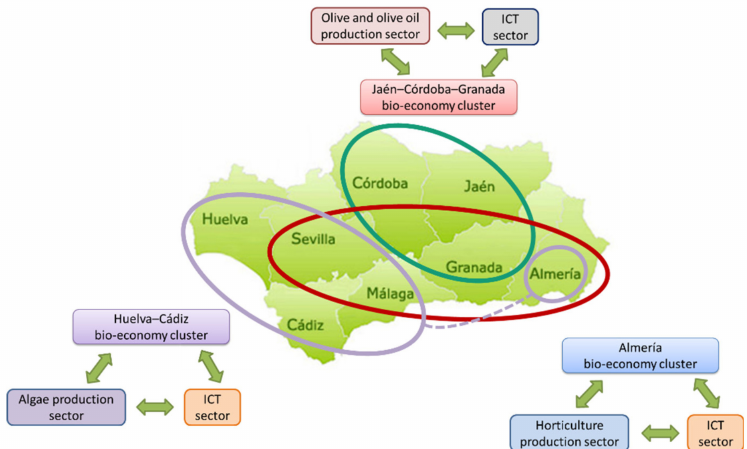
Figure 8. Cross-sector interconnections created in the frame of the DIH, Andalusia (Spain). Please note that for the sake of clarity, interconnections created by combined biomass supply chains are not depicted.